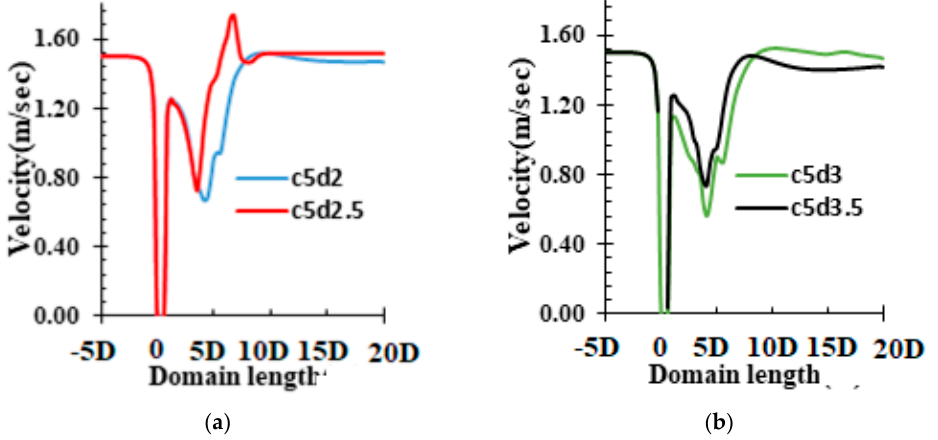
Figure 7. Velocity contour of the water throughout the domain at the center line of the turbine ( a ) TCT with tower 2, 2.5 m diameter ( b ) TCT with tower 3 and 3.5 m TCT with tower 2, 2.5 m diameter ( b ) TCT with tower 3 and 3.5 m diameter.